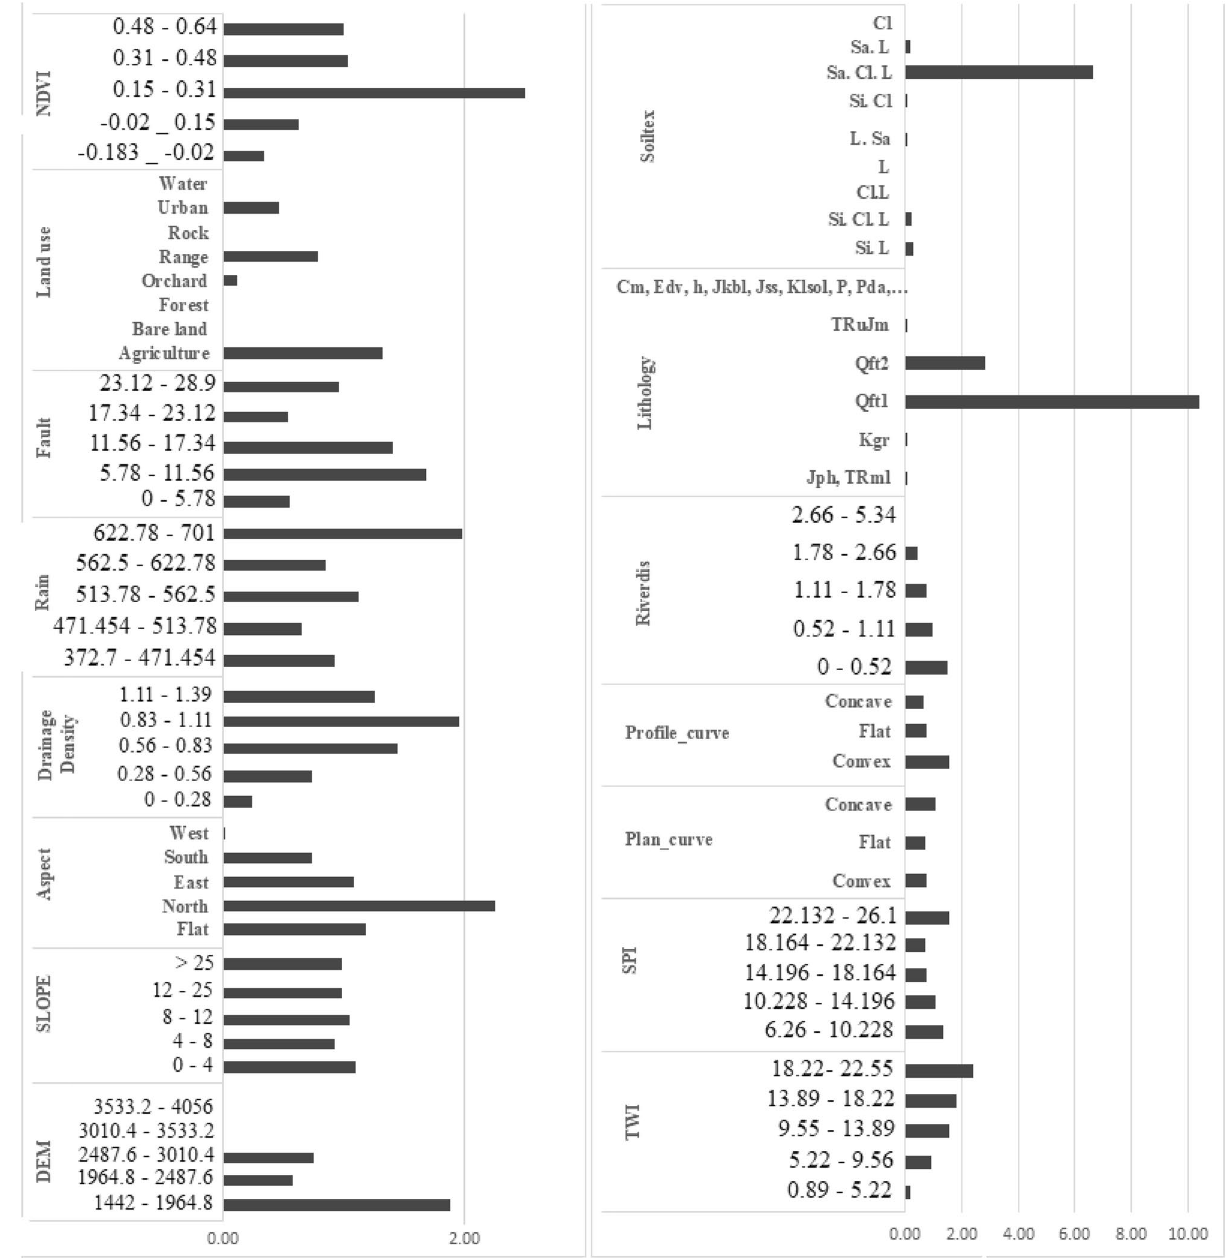
Figure 7. Spatial correlation between effective factors and GWR potential using FR